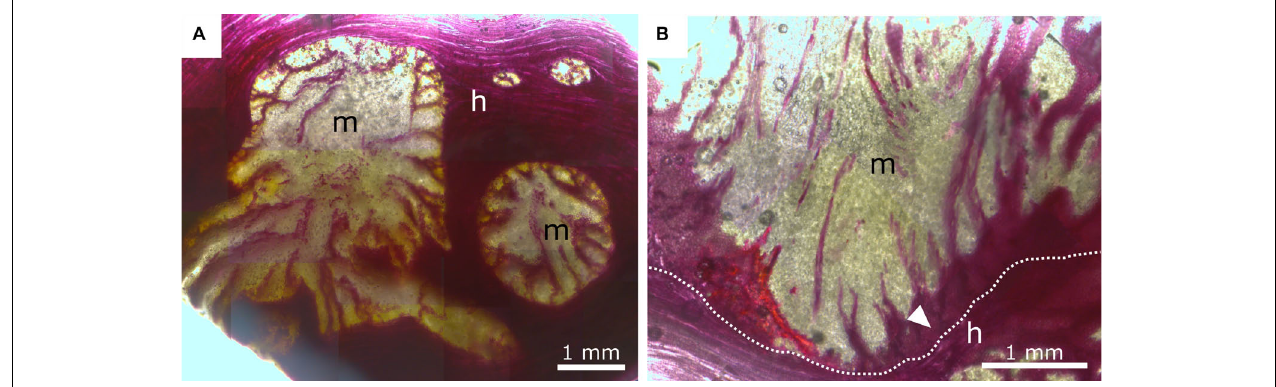
FIGURE 8 | Phloroglucinol-HCl staining of mistletoe sinkers (m) and host wood (h). Red indicates tissue lignification. (A) Transverse plane of mistletoe sinkers, tangential plane of host wood. (B) Longitudinal plane of mistletoe haustorium, tangential plane of host wood. The dotted line marks the interface between the mistletoe and its host; the white arrow marks lignified mistletoe